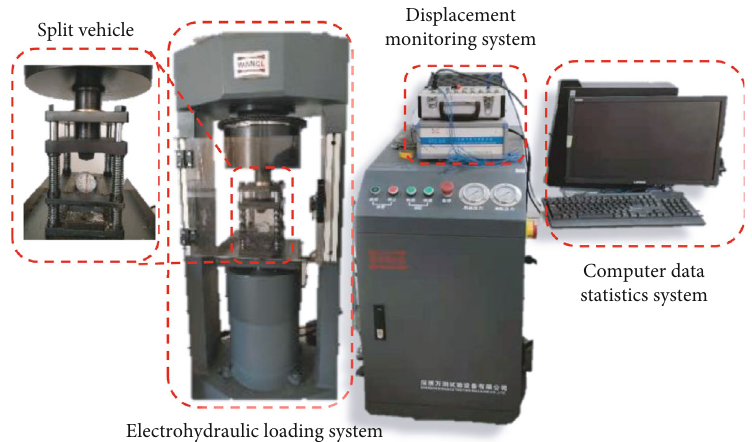
Figure 12: Wance electrohydraulic servo press.